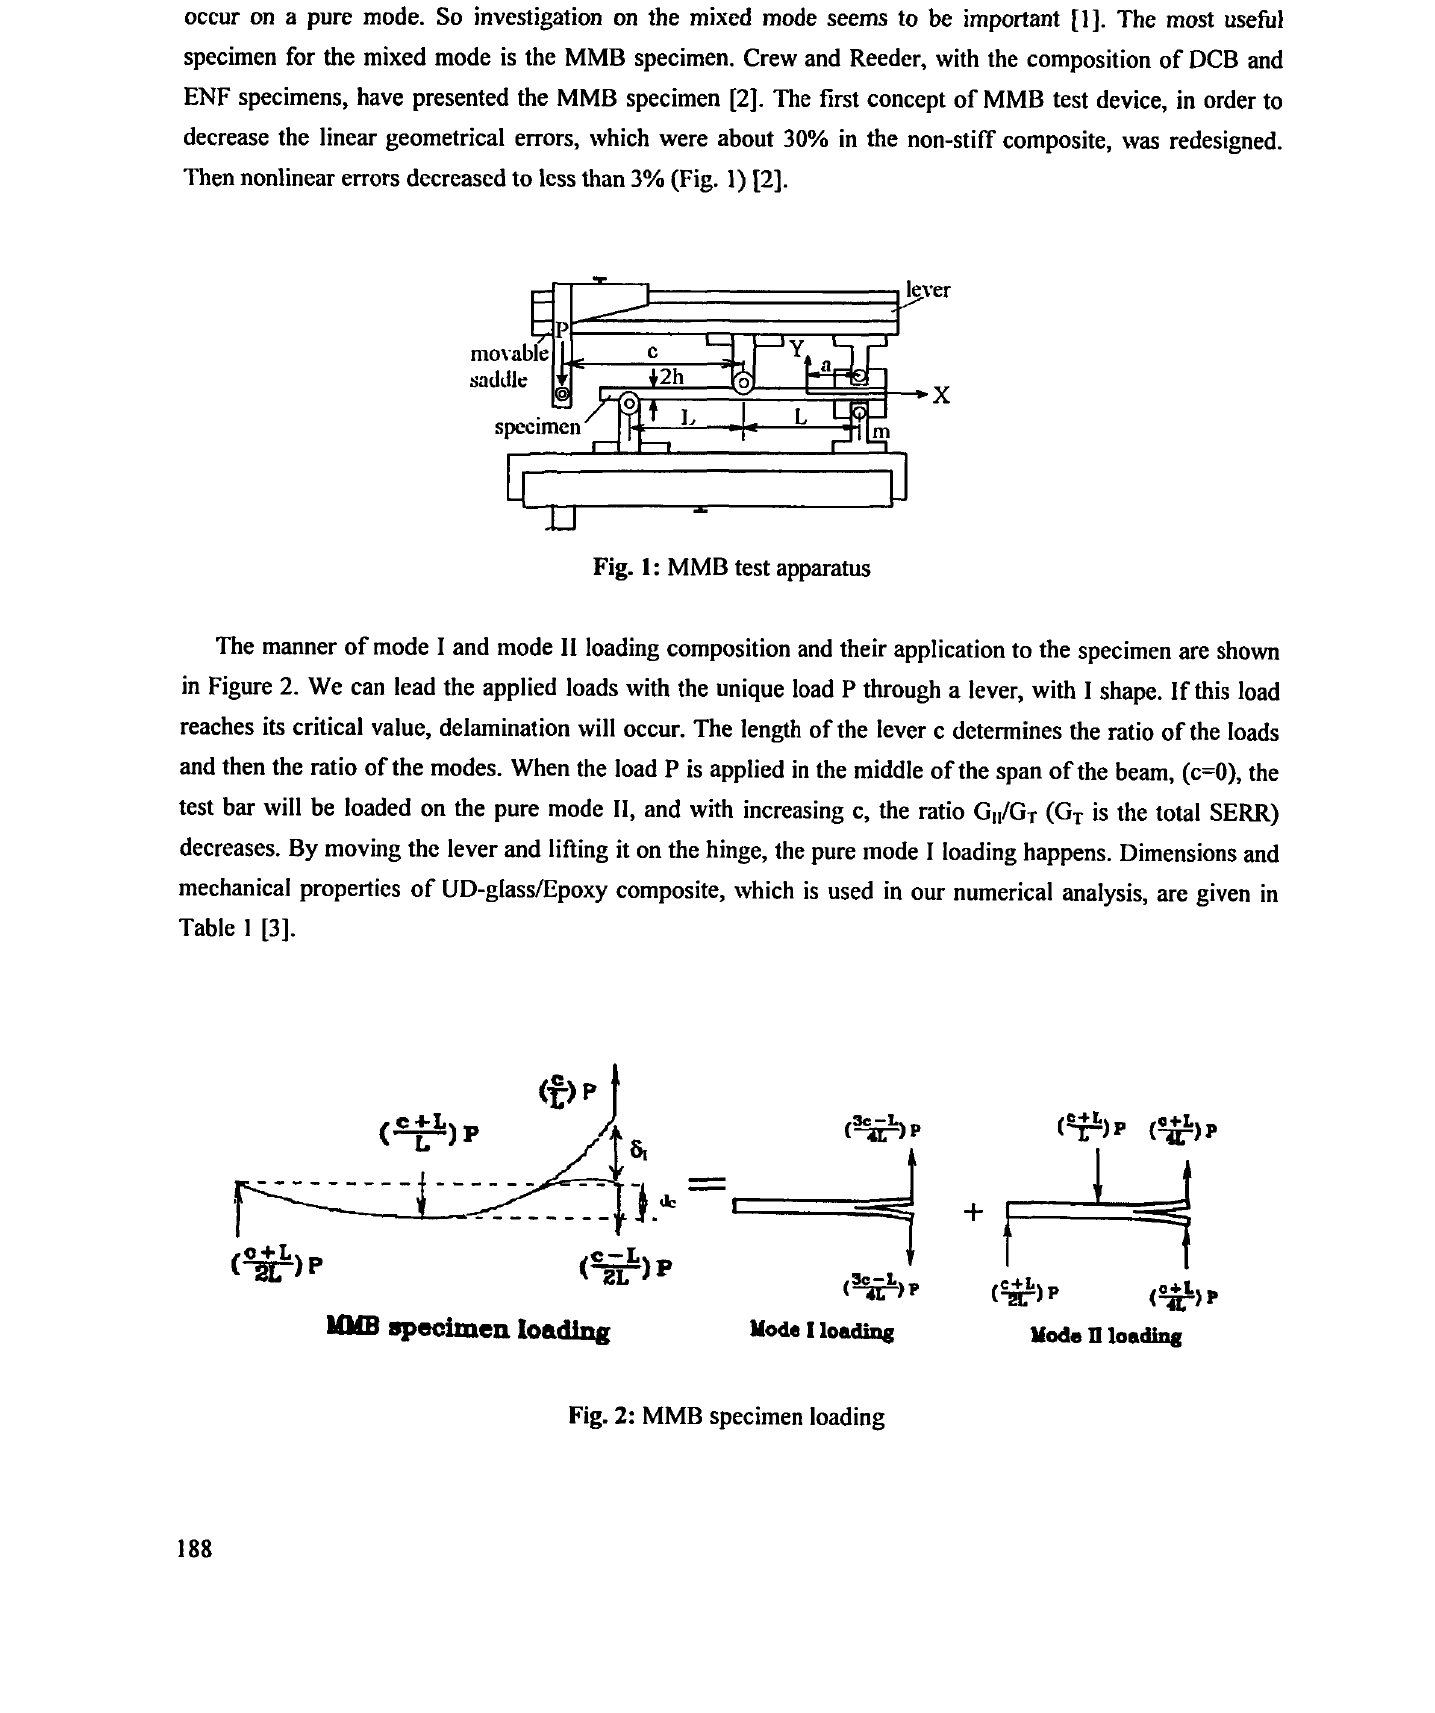
Fig. 2: MMB specimen